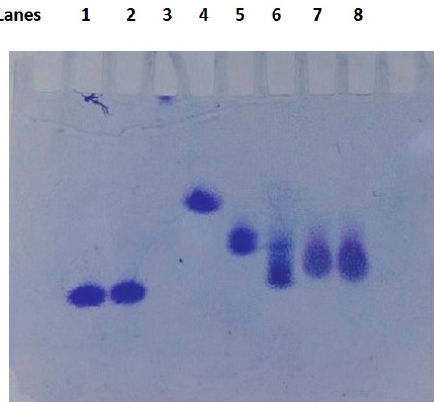
Figure 4. Isoelectric focusing (IEF) of G4-90/10 dendrimer. The top half of the gel is acidic and the bottom half is alkaline. Lanes 1 and 2 are lysozyme (pI 11.0); lane 3 is amyloglucosidase (pI 3.5; protein barely entered the gel); lane 4 is myoglobin (pI 6.8), lane 5 is ribonuclease A (pI 9.5), lane 6 is cytochrome c (pI 10.7); and lanes 7 and 8 are G4-90/10 dendrimers.